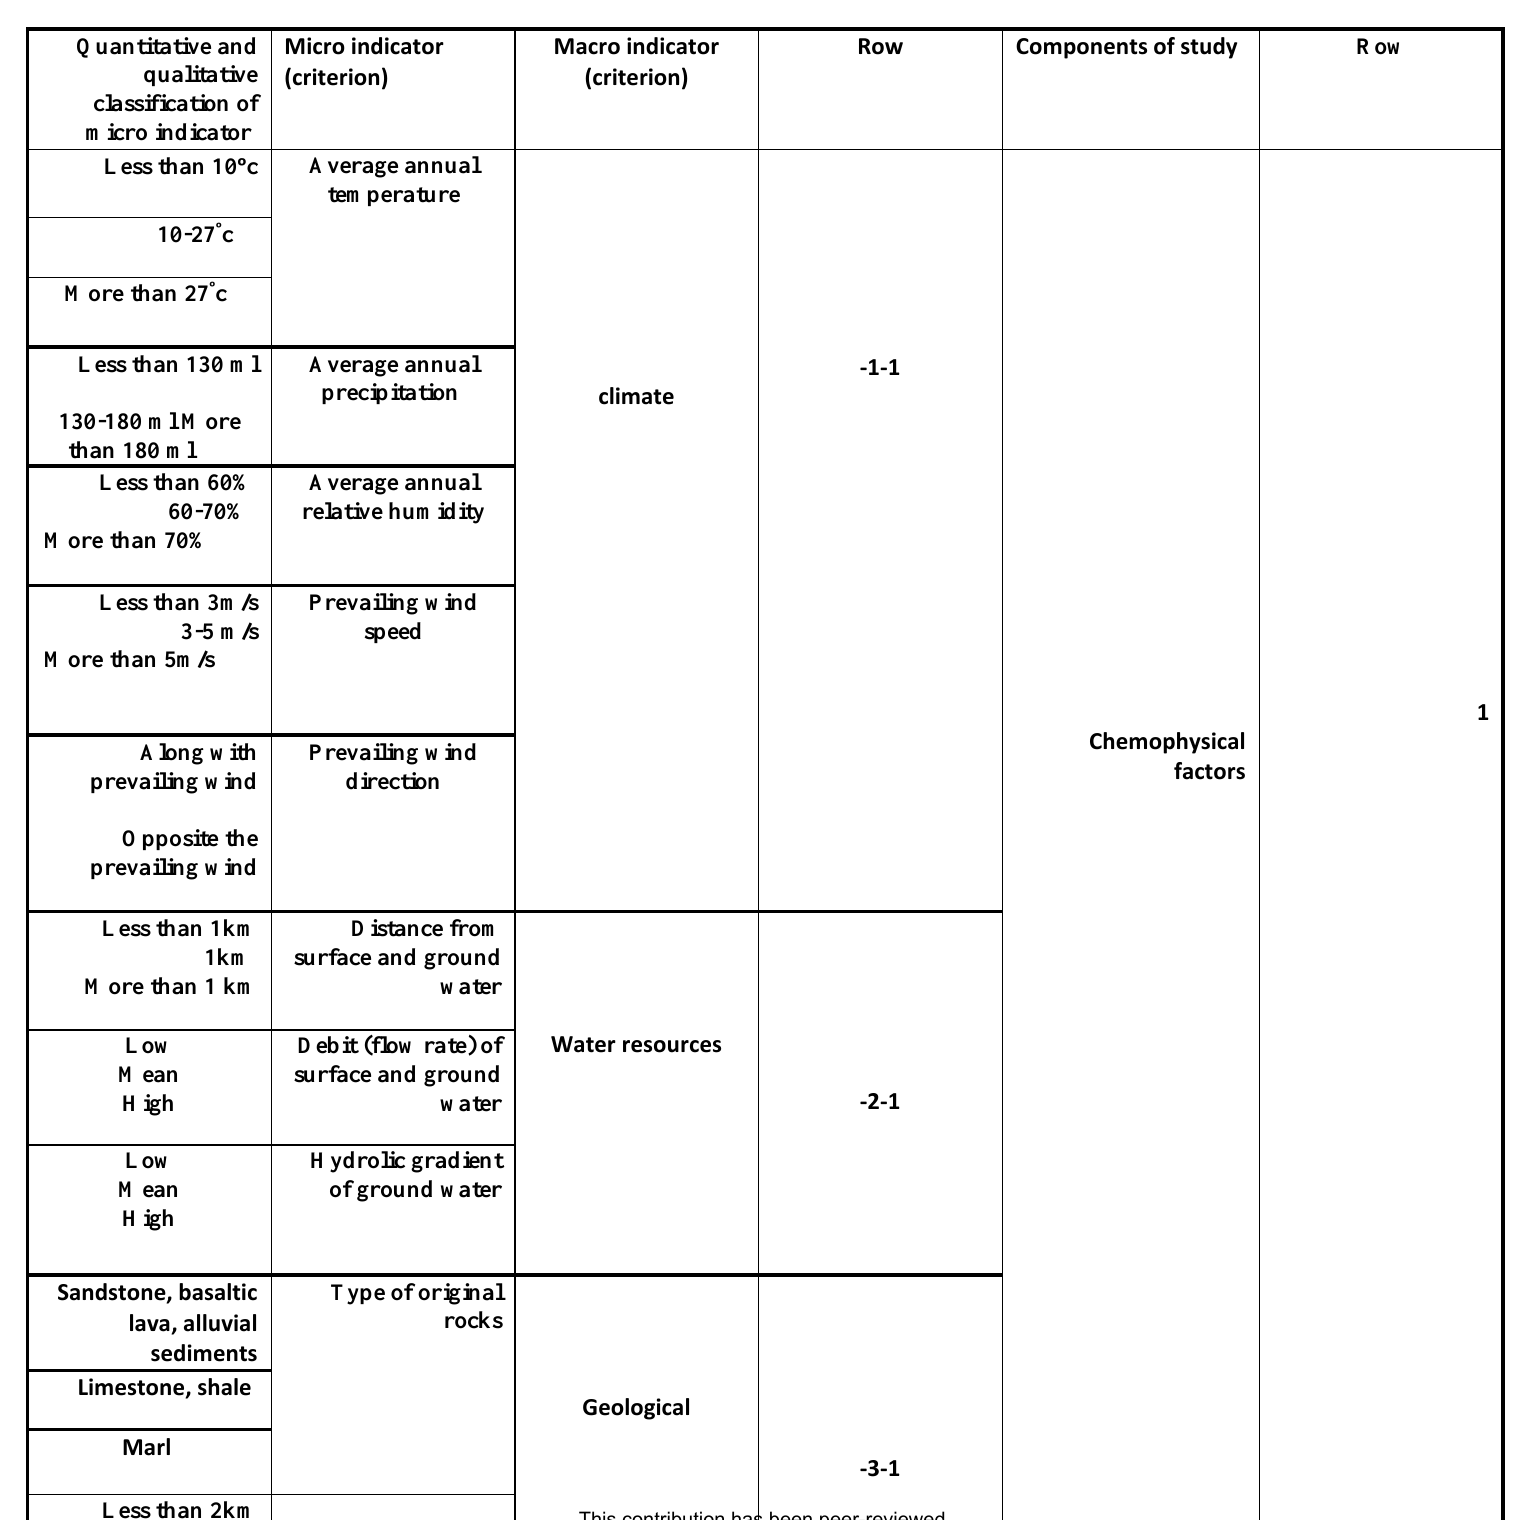
Table 1- The main criteria for regional landfill evaluation in Hormozgan